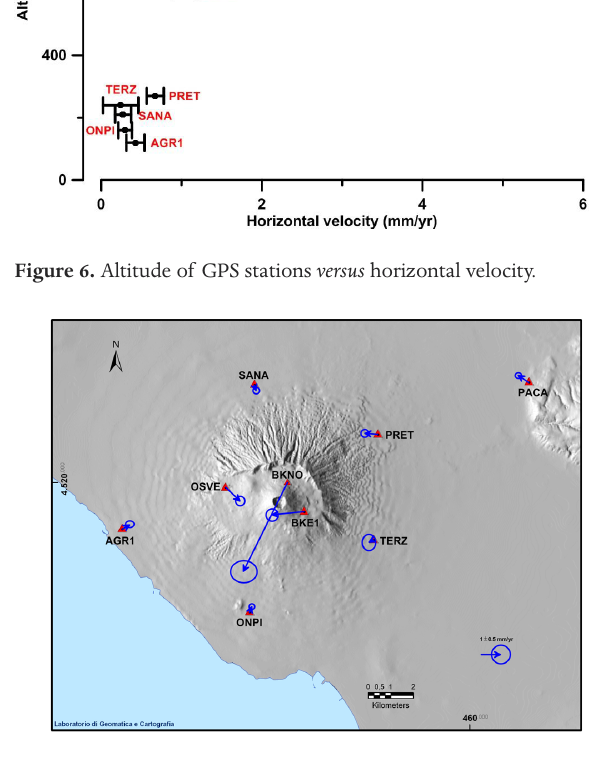
Figure 7. The horizontal GPS velocity field (relative to ENAV) and the 95 per cent confidence ellipse.